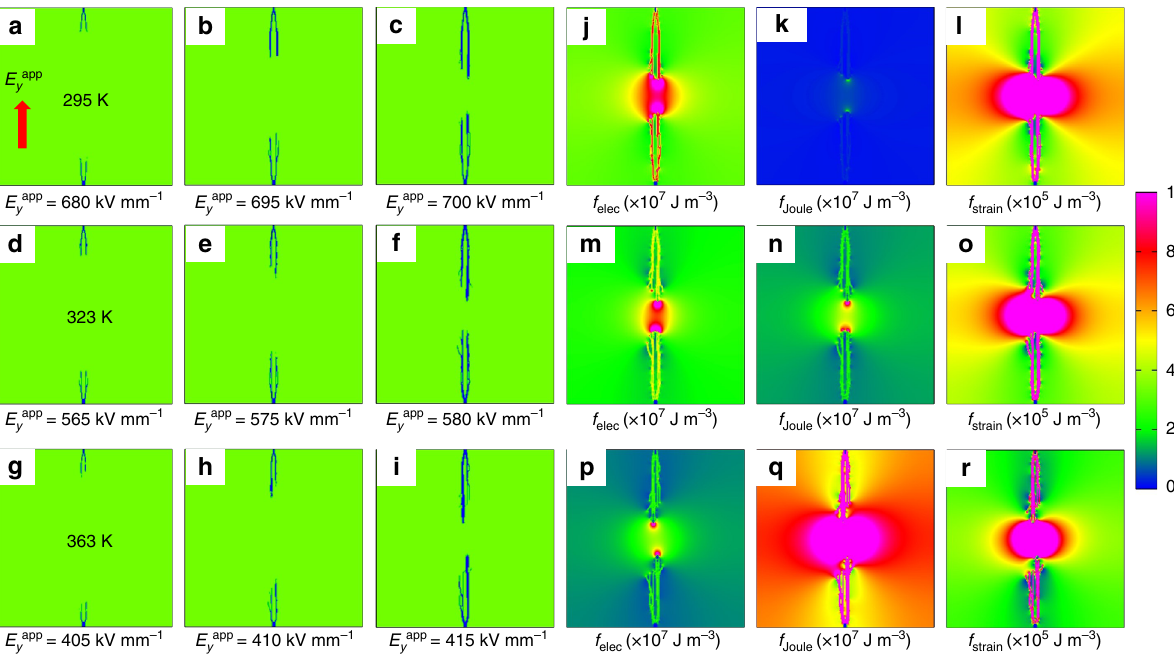
Fig. 1 Breakdown evolution and corresponding energy density distributions. The breakdown evolution processes of poly(vinylidene fl uoride- hexa fl uoropropylene) (P(VDF-HFP)) polymer predicted by the extended phase- fi eld model at different applied electric fi elds and temperatures of a – c 295 K, d – f 323 K, and g – i 363 K. The applied fi eld E app y is along the y direction and is shown by the red arrow in a . The initial breakdown phase is nucleated from the two needle electrodes. j – r show the electric energy density f elec , Joule heat energy density f Joule , and strain energy density f strain for the breakdown states of c , f , and